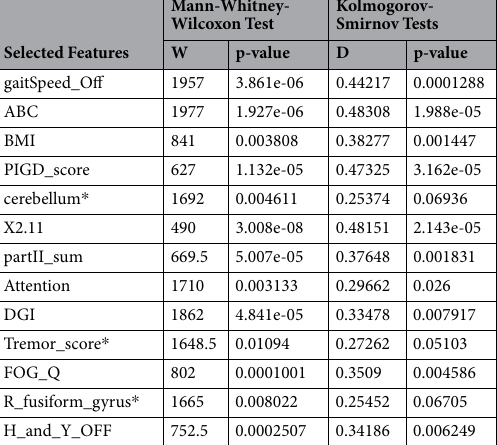
Selected Features